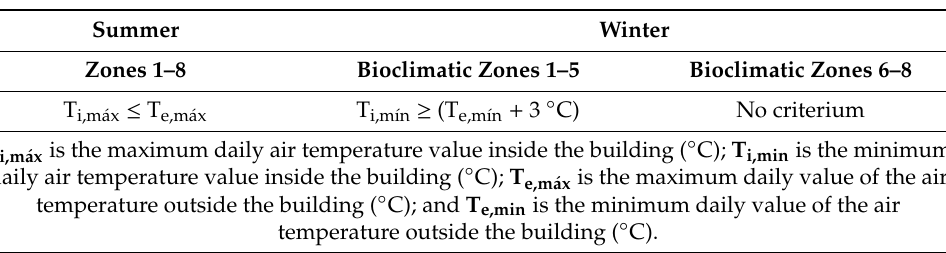
Table 7. Minimum criterion simulation for summer and winter conditions